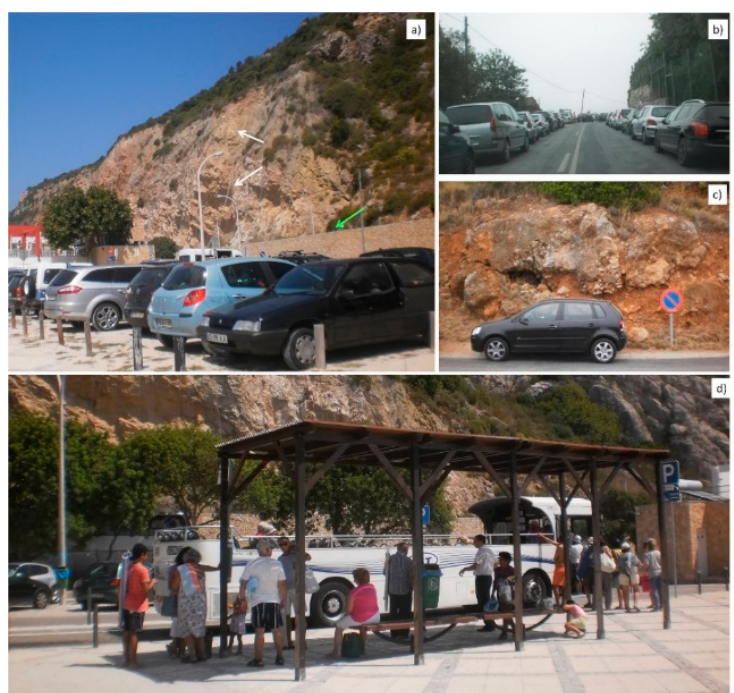
Figure 4. West part of Setubal: ( a ) Parking lot at a beach. White arrows: unstable cliffs protected by a net. Green arrow: reinforced wall is a secondary protection from falling debris (adapted from [13]); ( b ) road with parked cars; ( c ) people parked even on forbidden spots; ( d ) as of 2018, a shuttle bus was on service for free.